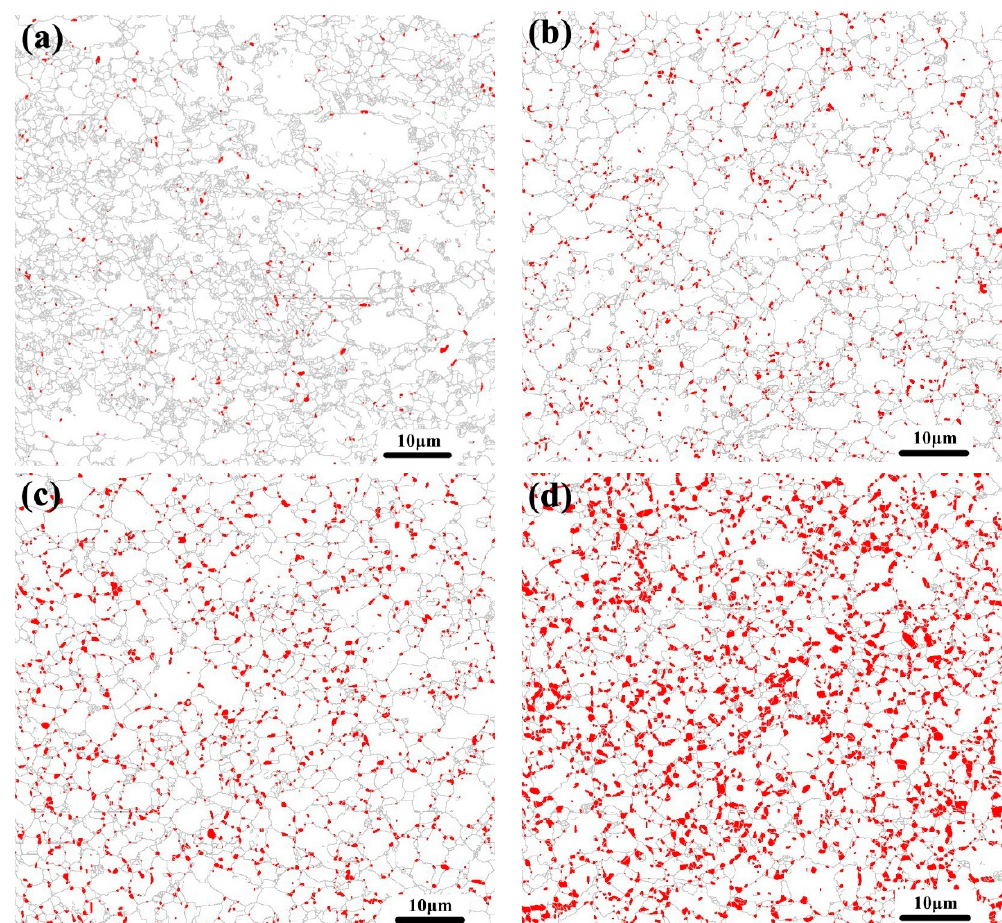
Figure 3. EBSD micrographs of samples at ( a ) 280 °C, ( b ) 310 °C, ( c ) 340 °C and ( d ) 370 °C. Where the white part is ferrite and martensite, and the red part is residual austenite.